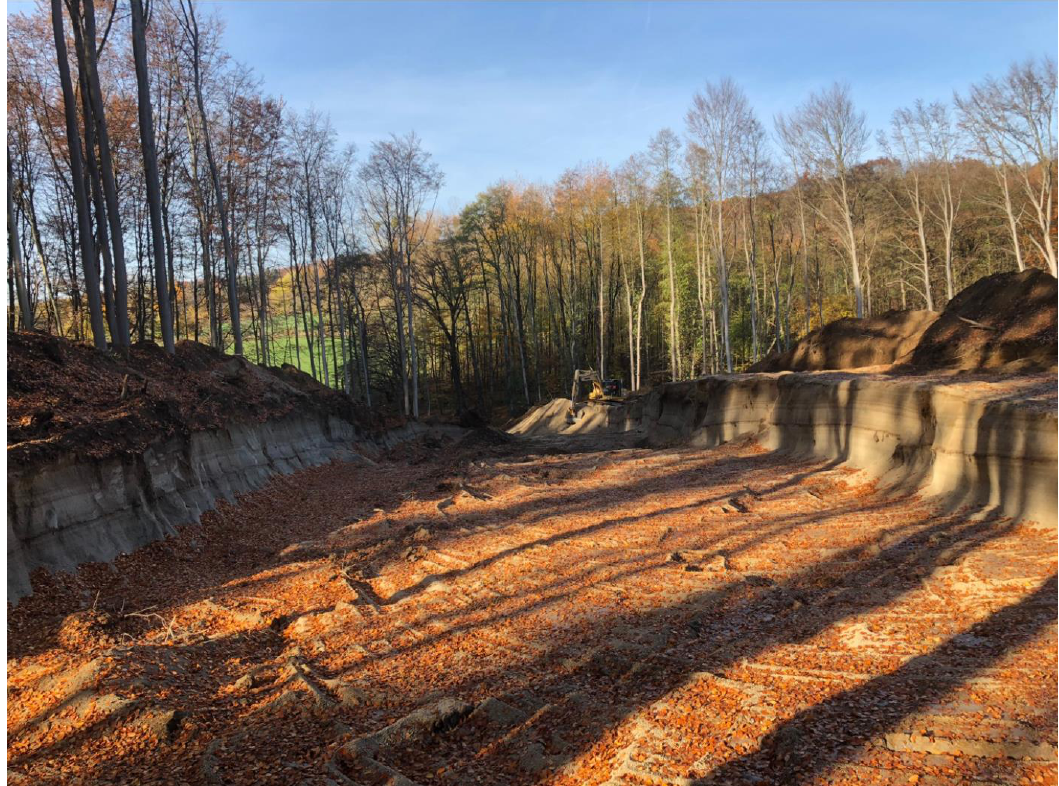
Figure 3. Beginning pumice excavation in forest district Bendorf, area CUT / CUT EX in late 2018 (Photo: Alexander Klein). Material for later backfilling and LST are visible on both sides. Area FOR is located on the left (West), excavation continued gradually to the right (East).